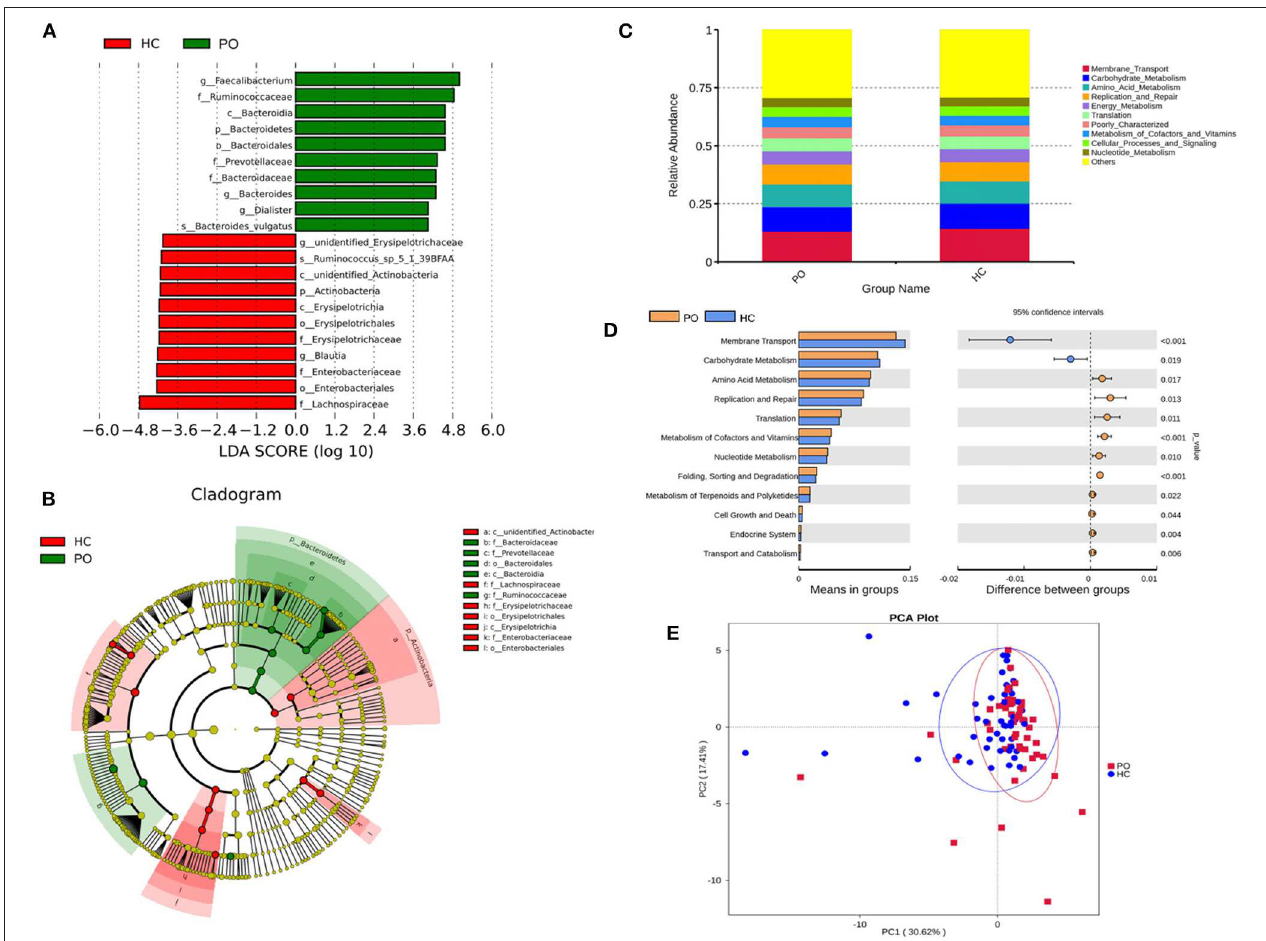
FIGURE 4 | (A) The LDA value distribution histogram shows the species with an LDA score greater than the set value (the default setting is 4), that is, the Biomarker with statistical differences between groups. The length of the histogram represents the impact of the different species (LDA score). (B) Evolutionary bifurcation graph, the circle of radiation from the inside to the outside represents the classification level from the gate to the genus (or species). Each small circle at different classification levels represents a classification at that level, and the diameter of the small circle is proportional to the relative abundance. The coloring principle: the species with no significant difference were uniformly colored yellow, the differential species Biomarker followed the group, and the red nodes represent the microbial group which played an important role in the red group. Green nodes represent microbial groups that play an important role in the green group. Where one of the groups is missing, it shows that there are no significant differences in species in this group, so the group is missing. The name of the species represented by the English letters in the picture is shown in the illustration on the right. (C) Level 2 relative abundance column chart, abscissa is grouping information; ordinates represent the relative abundance of functions; others represents the sum of the relative abundance of all functions other than these 10 functions in the diagram. (D) Inter-group functional difference analysis graph (for the illustration, please refer to the inter-group species difference analysis chart). (E) Display of PCA results of PICRUSt functional comments (PC1 = 30.62%; PC2 =